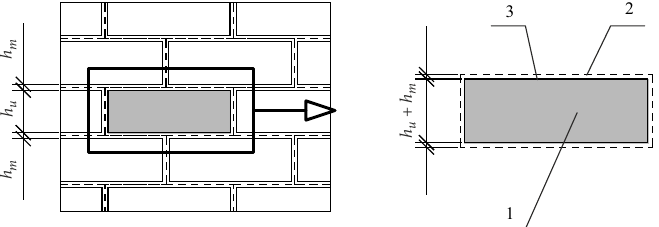
Figure 3. Scheme of simplified modeling: h u – unit height; h m – bed joint height; 1 – continual element; 2 – contact area; 3 – area of potential opening of crack (Lourenco et al.,